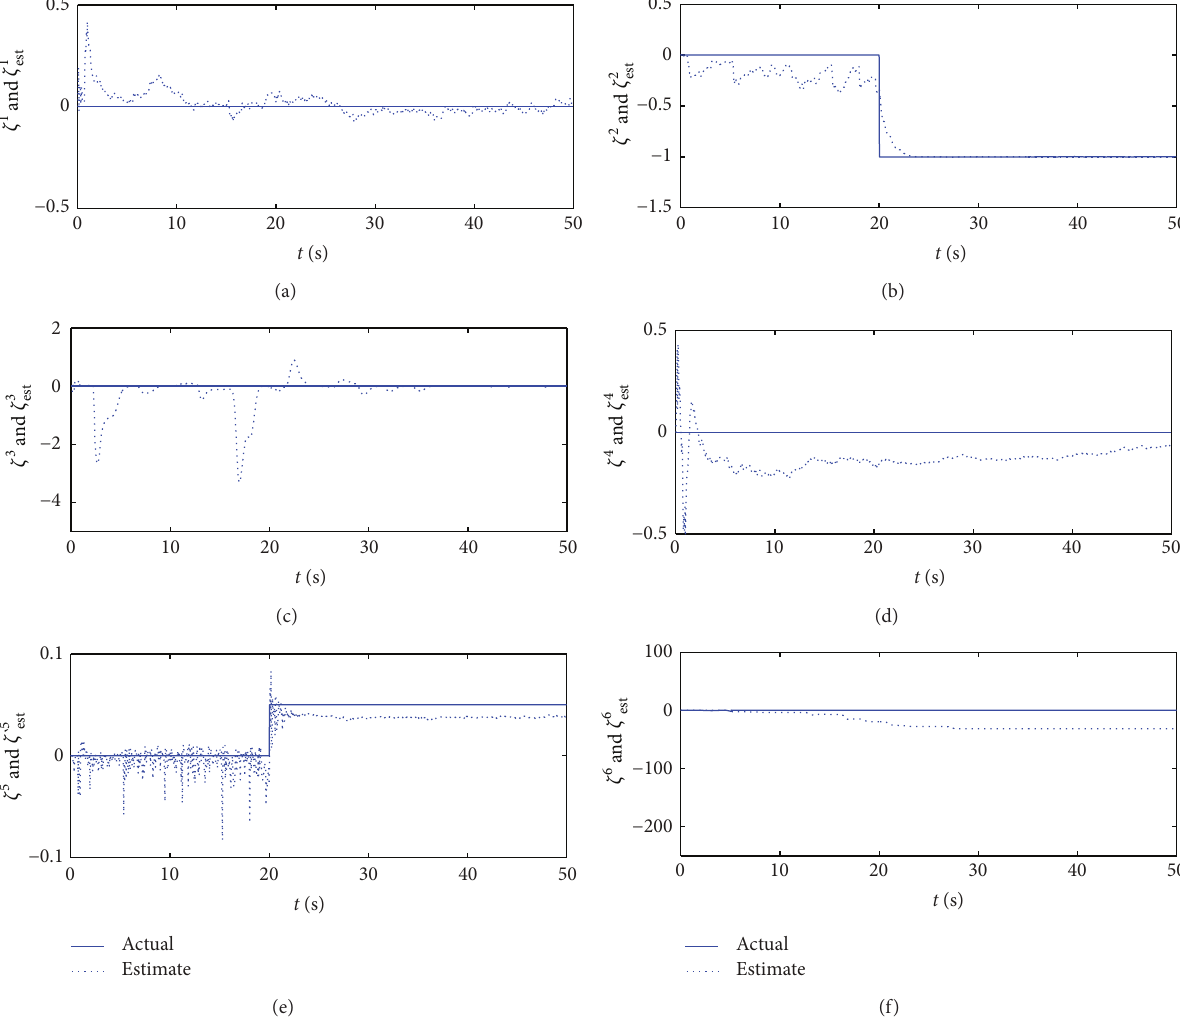
Experiment 2 (50% partial loss in stabilizer at 20